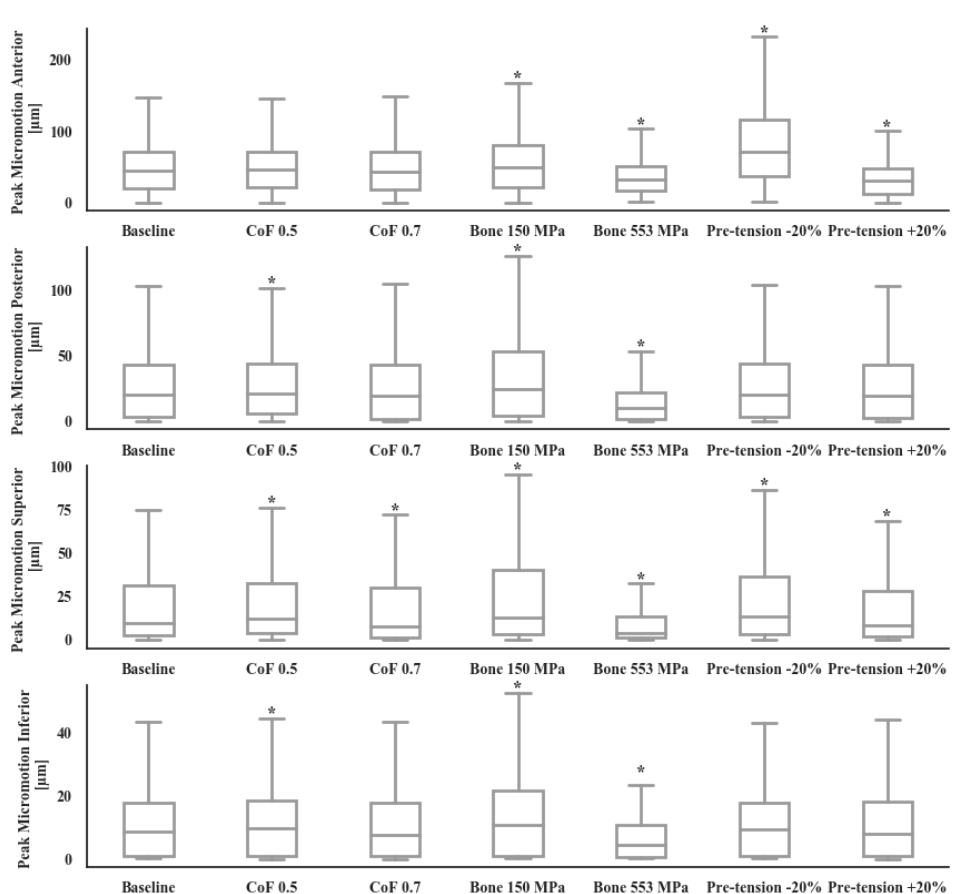
Figure 7. Change of the interface peak micromotion due to modification of different model parameters: bone Young’s modulus (150 and 553 MPa), coefficient of friction (CoF = 0.5 and 0.7) and screw pretension (load ±20%). *: paired t-test, p <0.01.